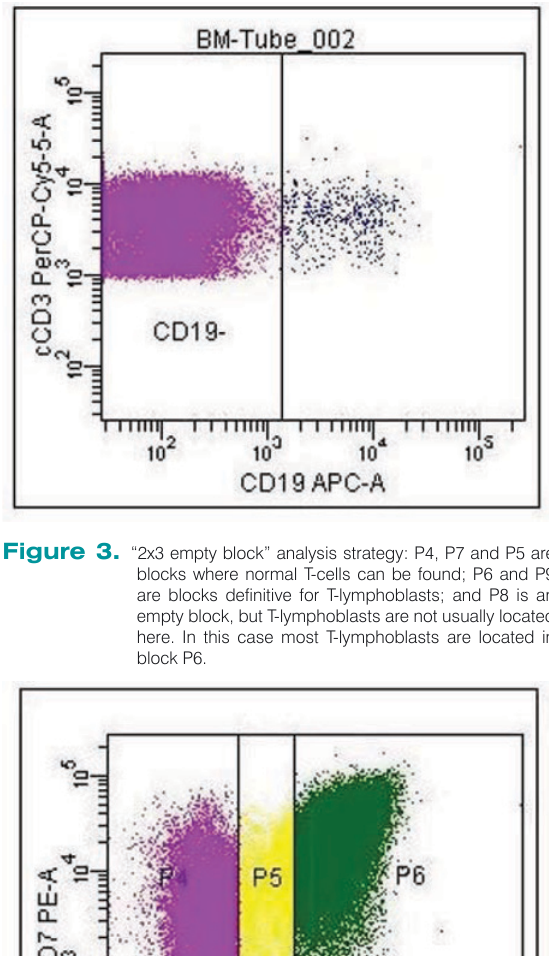
Figure 2. Exclusion of CD19 positive events: a rectangular region is set on CD19- events, and only those are analyzed further.